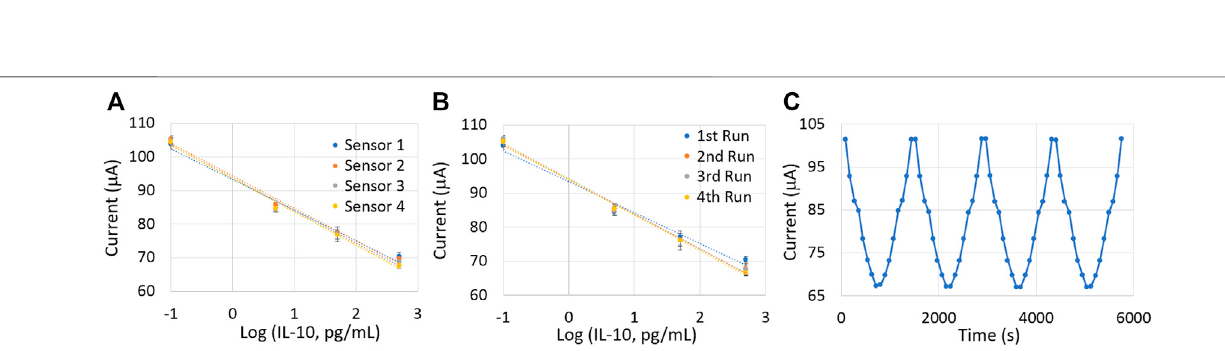
FIGURE9 |(A) Dynamic sensor response forincreasing IL-10concentrations. (B) Validation ofthe sensorin accuratelyestimating unknown IL-10concentrations.